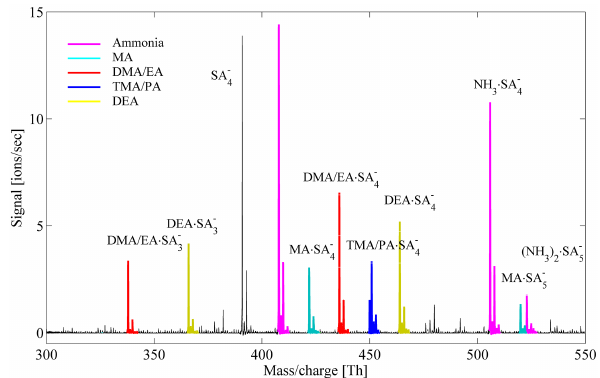
Figure 3. Operation principle of NO − CI system used to pro- 3 duce bisulfate–sulfuric acid–base clusters from ambient amines and added sulfuric acid present in the sample flow. Upper plot represents the flow profile inside the system. Lower plot depicts the electric potential inside the system. In the upper panel, the black thick line shows the ion trajectory in the case where all electric potentials are set to zero and ions “go with the flow”. In the lower panel, the black thick line shows electric fields guiding ions toward the centreline of the ion source, allowing ions to mix and interact with the sample and eventually be transported to the pinhole of the mass spectrom- eter. The original concept as presented by Eisele and Tanner (1993) was adopted by Jokinen et al. (2011) and coupled to the APi-TOF mass